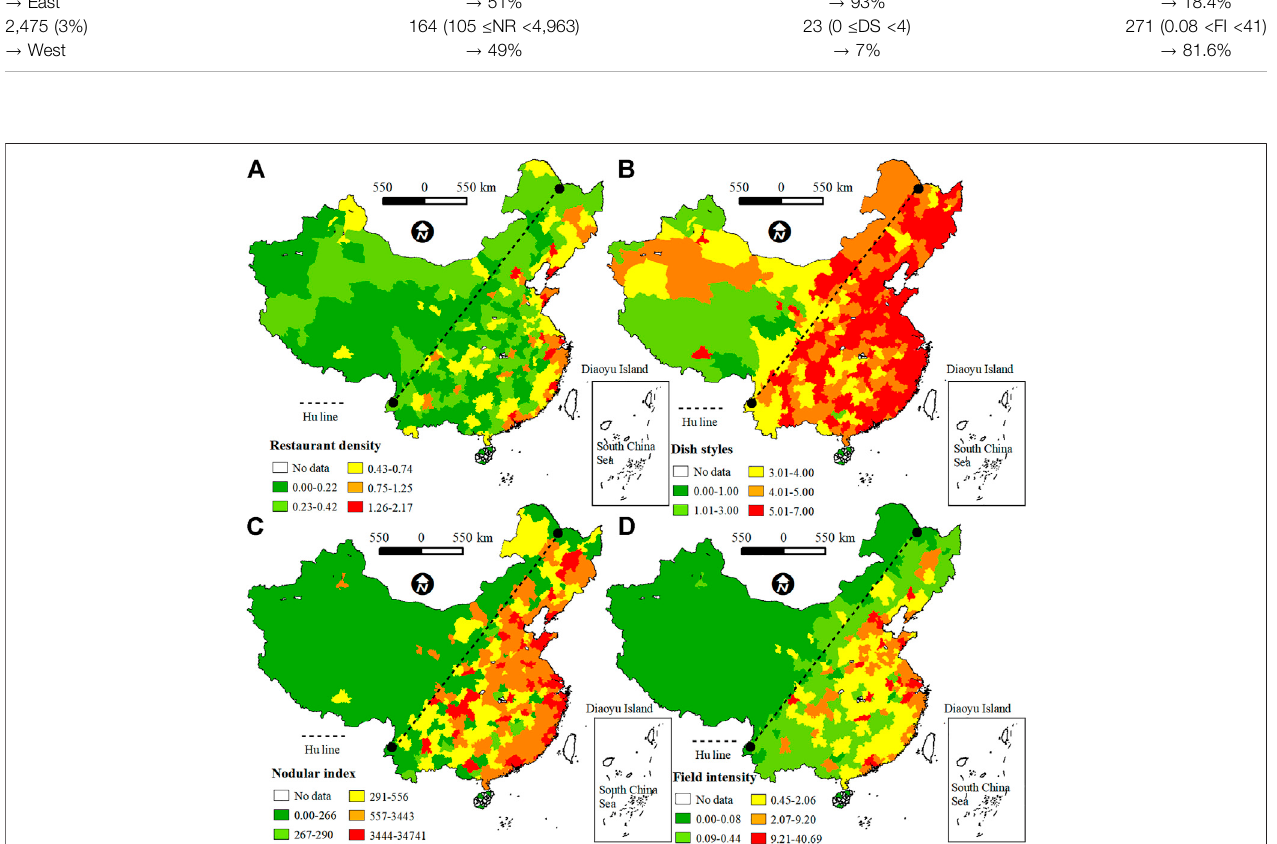
FIGURE 3 | Spatial inequality of Japanese cuisine distribution in China. (A) Shows the spatial imbalance of the restaurant density of Japanese cuisine between cities. (B) Shows the spatial imbalance of the dish styles of Japanese cuisine between cities. (C) Shows the spatial imbalance of the nodular index of Japanese cuisine between cities. (D) shows the spatial imbalance of the fi eld intensity of Japanese cuisine between cities.